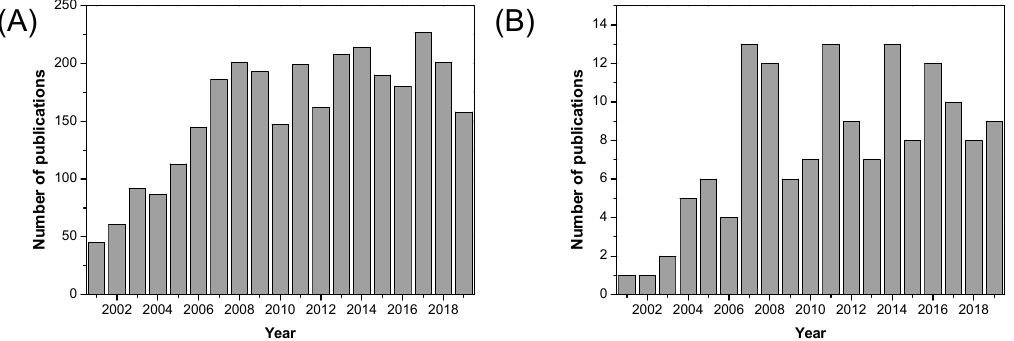
Figure 14. Number of publications in the period of 2001–2019 indexed in the Web of Science: ( A ) keywords: metallic oxide AND fuel cell; and ( B ) keywords: metallic oxide AND fuel cell AND proton exchange membrane. Source: www.webofknowledge.com.